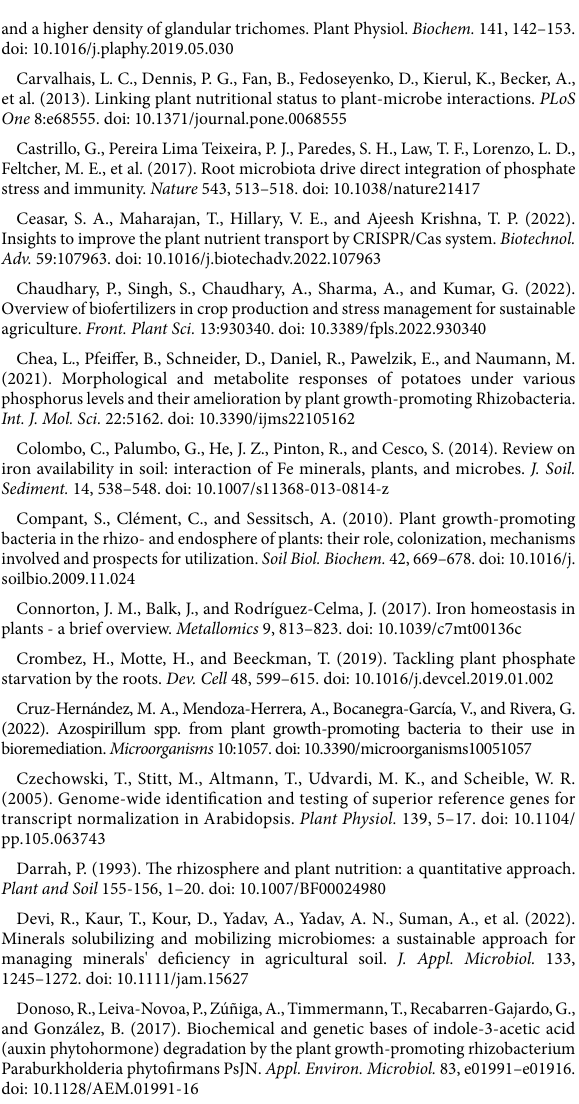
SUPPLEMENTARY FIGURE 2 Effects of beneficial bacteria on jasmonic acid and ethylene-related genes in Arabidopsis thaliana grown in different phosphate sources. Quantitative RT-PCR determinations of relative expression levels of the genes related to auxin synthesis LOX2 ( LIPOXYGENASE 2 ) and PDF1.2 ( PLANT DEFENSIN 1.2 . Plants were exposed to 1mm KH 2 PO 4 and 0mM Ca 3 PO 4 ; Left panel) or 0.1mm KH 2 PO 4 /0.99mM Ca 3 PO 4 (right panel) for 0, 2, 24 h or 7 days (d). Simultaneously, plants were non- inoculated (WB) or inoculated with Paraburkholderia phytofirmans PsJN (PsJN) or Azospirillum brasilense Sp7 (Sp7). Normalization was performed with the housekeeping SAND family gene (AT2G28390). Asterisks indicate statistical significance among treatments in a particular time compared to the WB group (Two-way ANOVA and multiple comparisons, p <